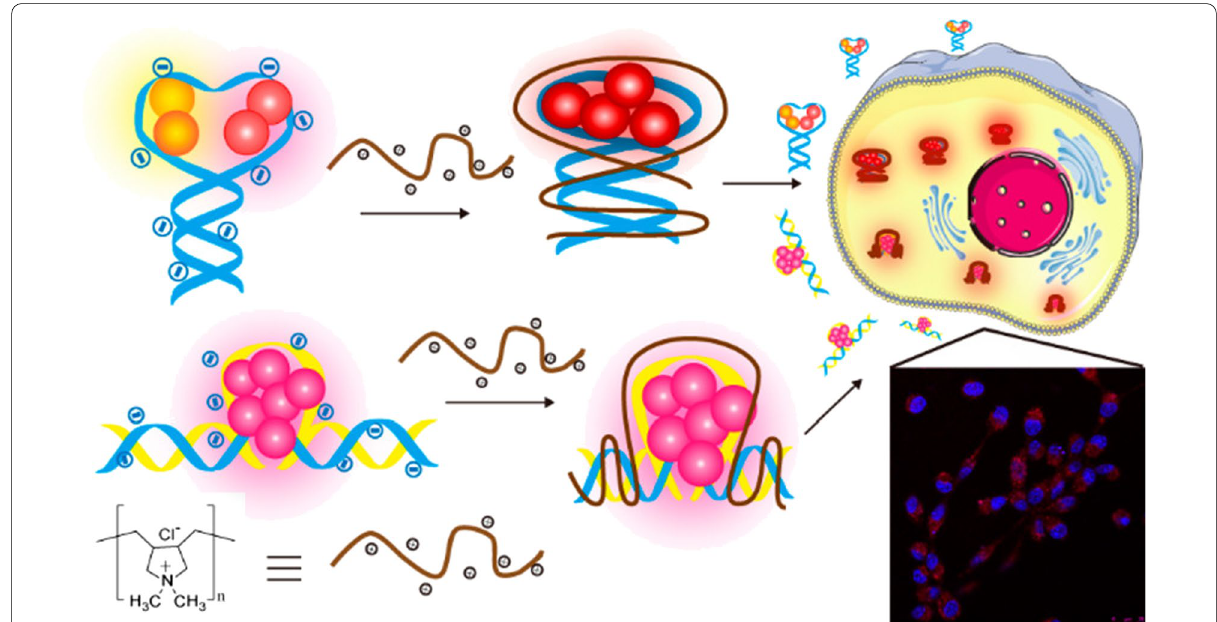
Fig. 5 Formation of FL DNA–Ag NC–Cationic Polyelectrolyte Complexes for Cell Imaging